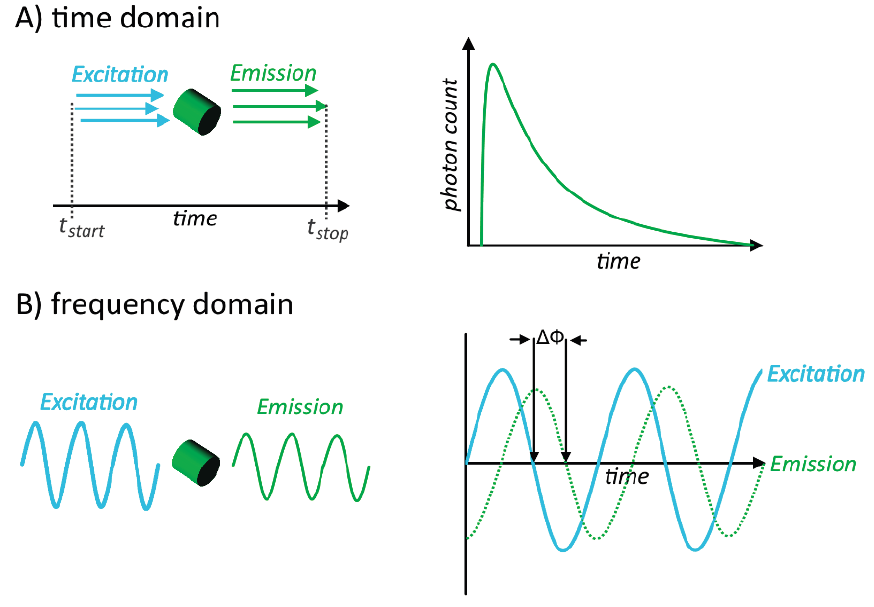
Figure 4. The basic measuring principle of fluorescence lifiteme in ( A ) time-domain, where the time between the exciting light pulse, and emission detection is measured in multiple single measurements to obtain a specific photon count curve; and ( B ) frequency domain, in which the delay in the oscillation of the electromagnetic wave is